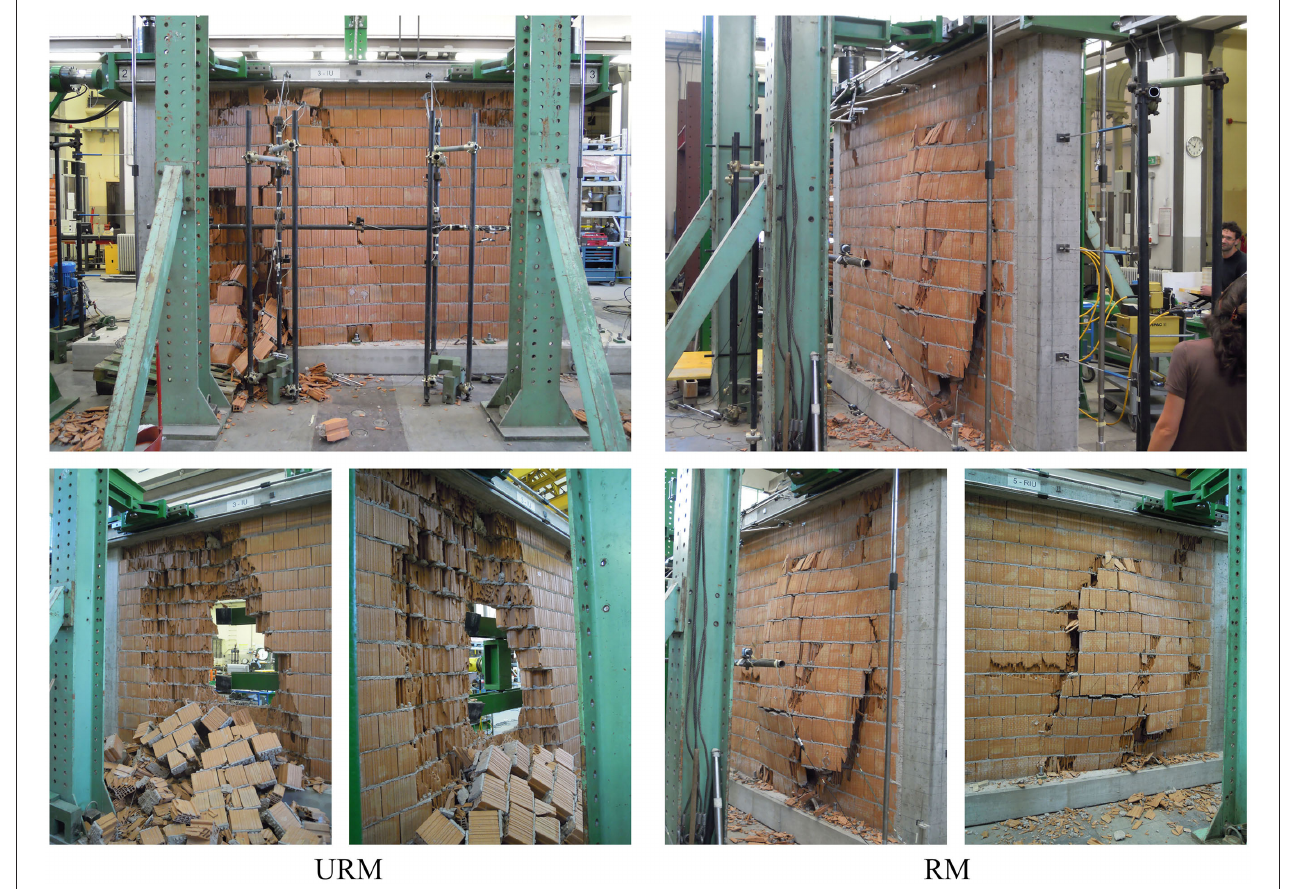
FIGURE 12 | Expulsion of masonry portions at ultimate deflection in unreinforced masonry specimens (left); out-of-plane damage at ultimate deflection in reinforced masonry specimens